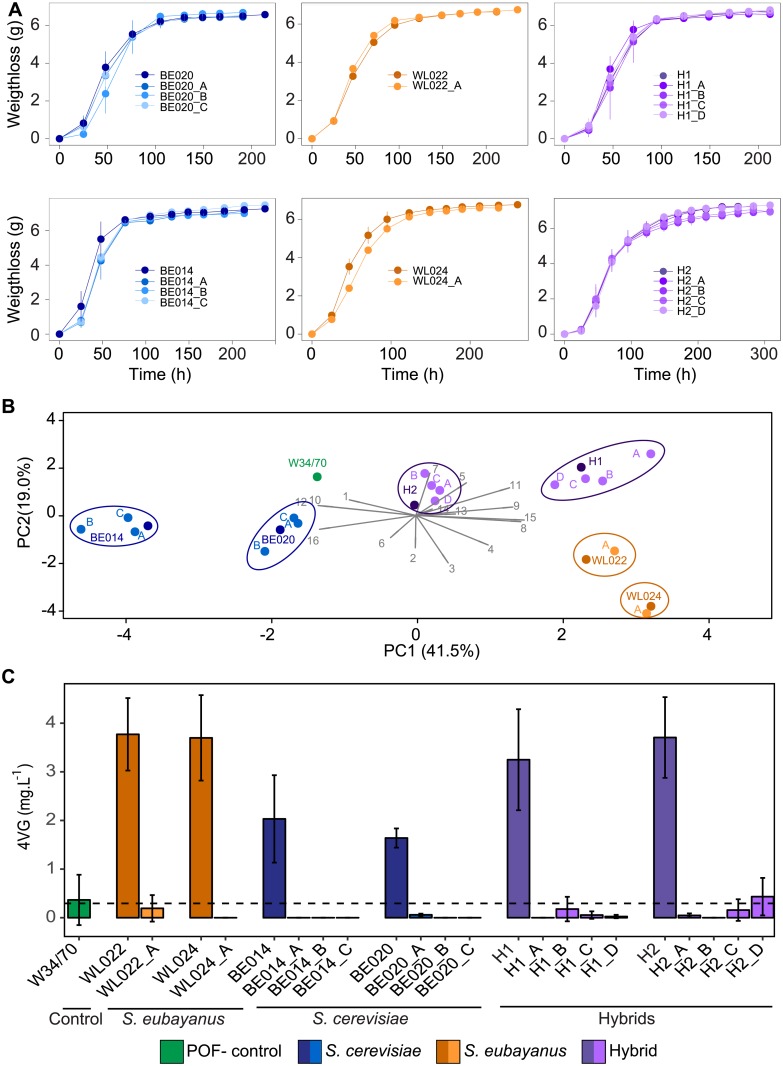
Gene edited variants behave similar to their parental strains in lab scale beer fermentations, except for their POF phenotype.(A), fermentation profiles of BE020, BE014, WL022, WL024, H1 and H2 with their respective gene edited mutants. (B) Principle Component Analysis (PCA) based on the production of 16 different metabolites, describing 60.5% of the total variability. Eigenvectors of the different variables are depicted with numbers ranging from one to 16. 1 = Ethanol, 2 = glycerol, 3 = SO2, 4 = acetaldehyde, 5 = ethyl acetate, 6 = ethyl propionate, 7 = propyl acetate, 8 = isoamyl alcohol, 9 = isobutyl acetate, 10 = ethyl butyrate, 11 = isoamyl acetate, 12 = ethyl hexanoate, 13 = phenetyl alcohol, 14 = ethyl octanoate, 15 = phenetyl acetate and 16 = ethyl decanoate. (C) 4VG production (measured via HS-GC-FID; mg.L -1) of W34/70 (green), S. eubayanus WL022 and WL024 (dark orange) with their respective gene edited variants (light orange), S. cerevisiae BE014 and BE020 (dark blue) with their respective gene edited variants (light blue), as well as for artificial interspecific hybrids H1 and H2 (dark purple) with their gene edited variants (light purple). Error bars represent the standard deviation of two biological replicates. Dotted line represents the flavor threshold of 4VG in beer (0.3mg.L-1), as reported in [29].